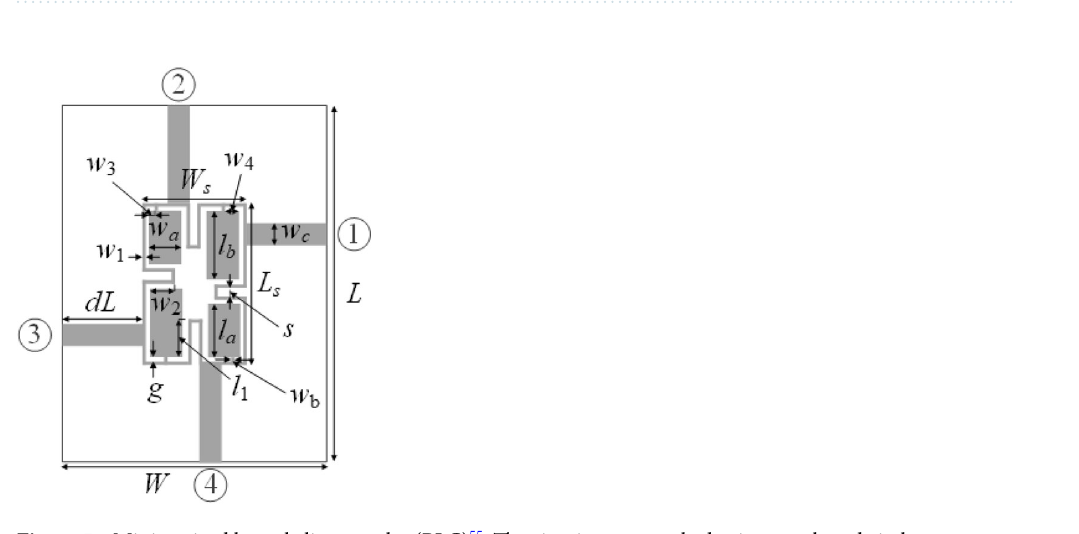
Figure 4. Flow diagram of the proposed optimization with design specification management through intelligent decision-making.